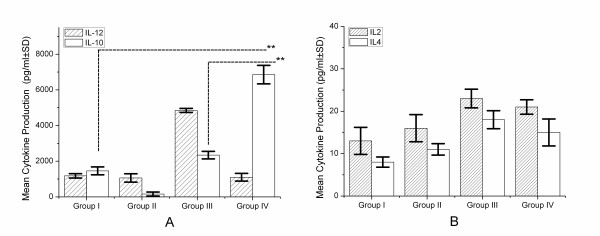
Serum cytokine levels in response to L. monocytogenes infection. Individual serum samples were assayed for levels of IL-12 and IL-10 (A), IL-2 and IL-4 (B). The levels of IL-12 were significantly lower in infected Se-deficient mice in comparison to infected-adequate mice. Results are expressed as the mean concentration per group ± standard deviation (SD). *p < 0.05, **p < 0.01.